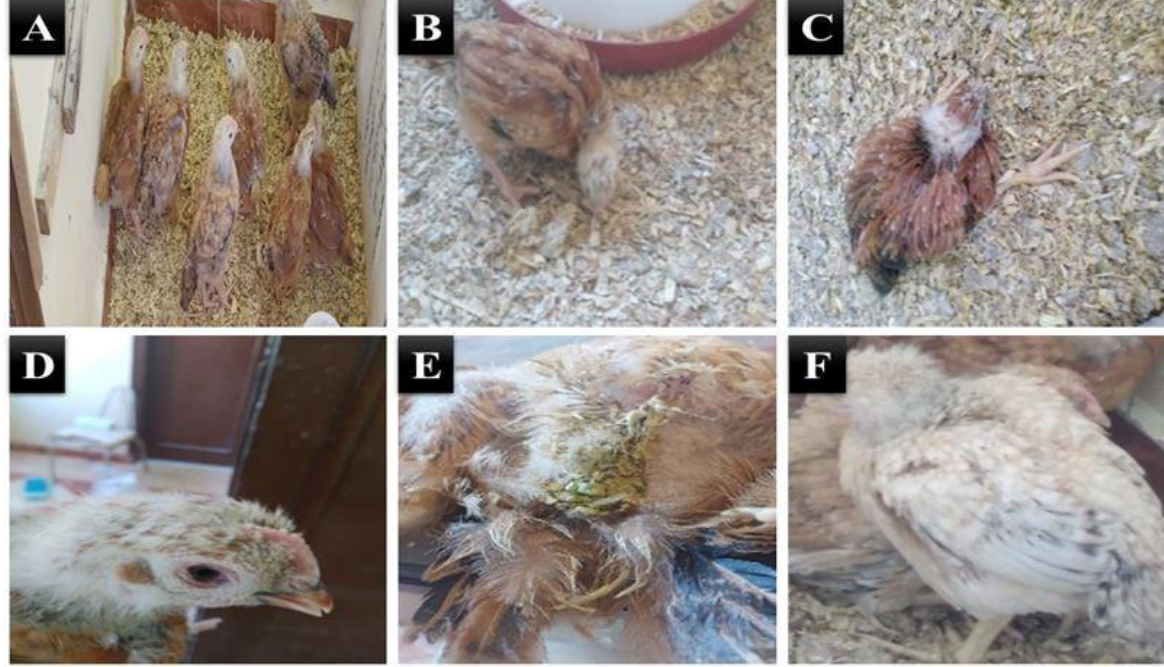
Fig 3: Clinical investigation of Sasso chickens in control and treated groups with ECV extract challenged with VNDV genotype VII. (A): Group (I) with the active condition (B): Nervous signs (torticollis), (C): Recumbent with paralysis of legs (D): Conjunctivitis, nasal discharge and swollen head (E): Greenish diarrhea (F): Depression with ruffled feathers